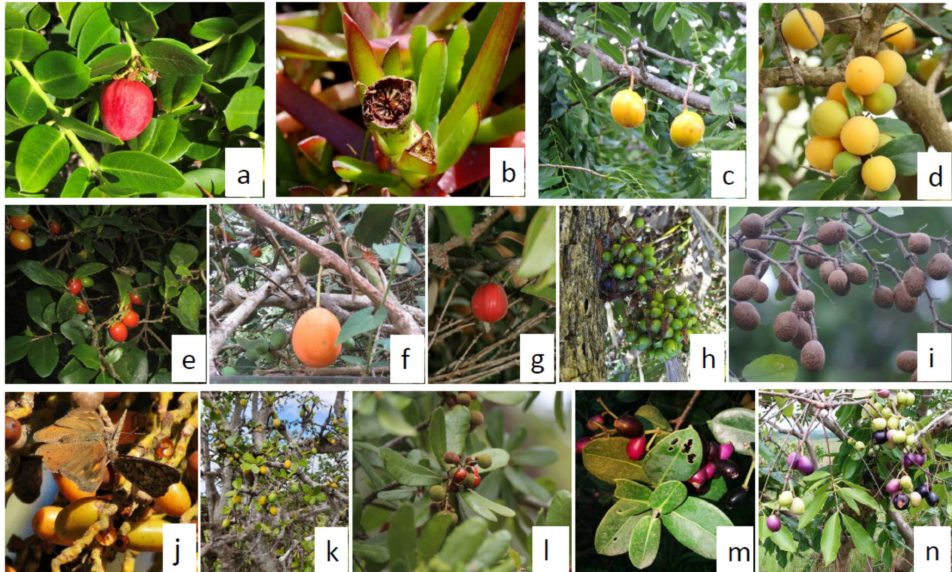
Figure 1. ( a ) Carissa macrocarpa (Maryann Robledo; https://www.inaturalist.org/photos/51979217; accessed 6